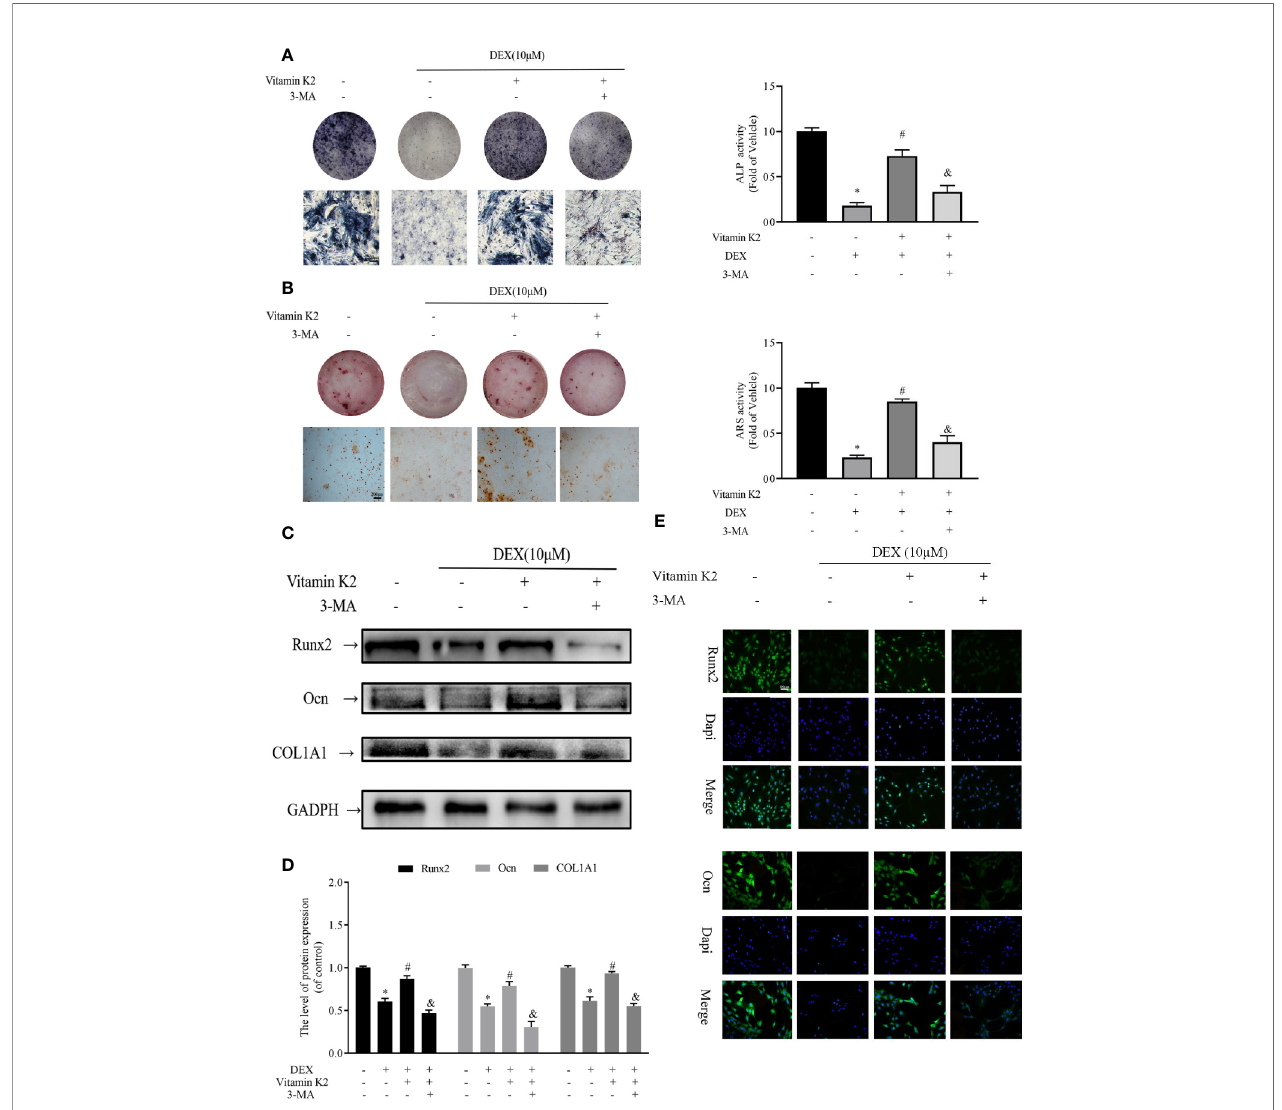
FIGURE 4 | Autophagy and mitophagy are both necessary for osteoblast differentiation and mineralization. Primary osteoblasts were initially treated with 10 m M Dex for 24 h, then 10 − 6 M VK2 without/with 5 mM 3-MA was added into the culture medium for another 48 h. After treatment, the osteoblasts were cultured in osteogenic medium for indicated days. (A) Osteoblastic functions were detected by ALP staining on the 7th day; (B) and mineralization degree by the ARS staining on the 21st day; (C) The osteogenic protein expression levels of the above indicators were detected by western-blotting and (E) the analysis of the results; (D) Representative immuno fl uorescence images of the above indicators, counterstained with Dapi. Data was expressed as mean ± SEM, n = 5; *p < 0.01 vs. control group, # p < 0.01 vs. DEX group, & p< 0.01 vs. DEX+VK2